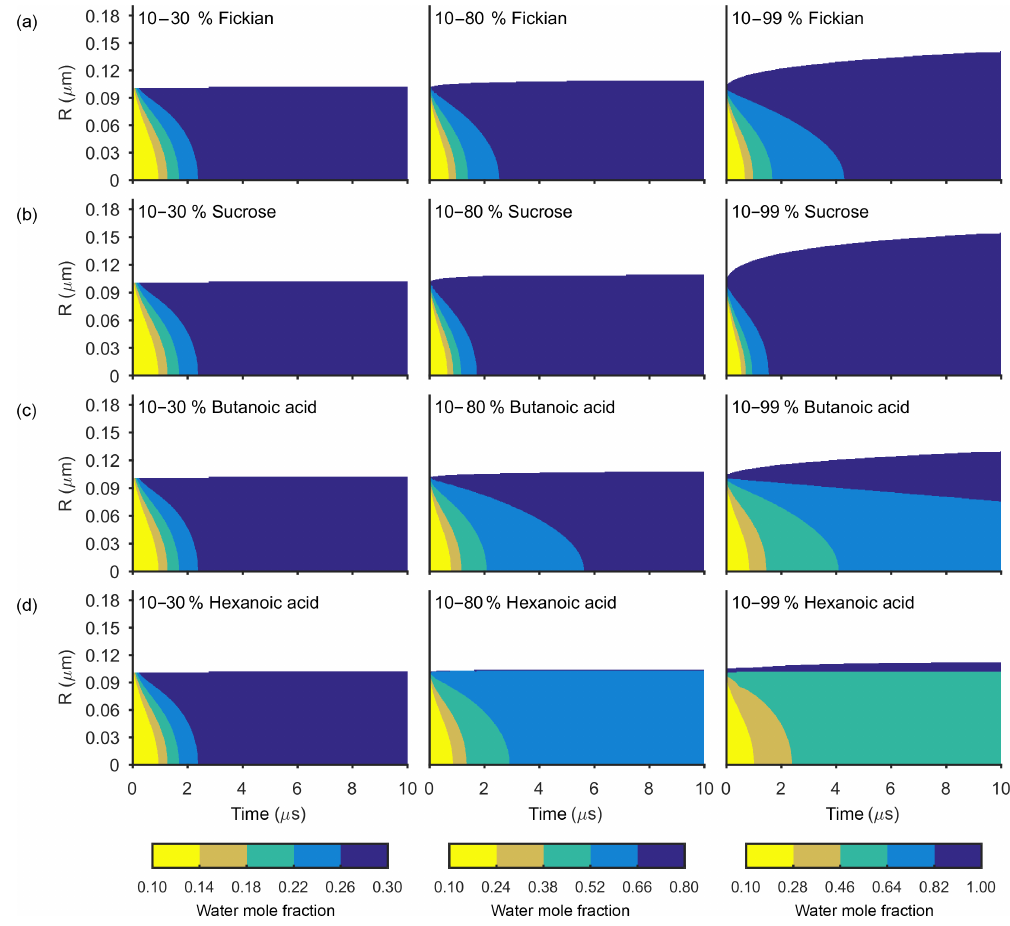
Figure 3. The change in water mole fraction as a function of radius through time after an initial increase in relative humidity from 10 to 30, 80 and 99%, at t = 0 in the left and right column respectively. Note that there is a different colour scale for each column to ensure clarity in the rate of mixing. The rows correspond to different non-volatile substances, with an arbitrary ideal species in the Fickian case, sucrose, butanoic acid and hexanoic acid from top to bottom. These simulations correspond to the Darken diffusion coefficient and thermodynamic factors given in Fig. 2. The aerosol particles were initialized with a radius of 1 × 10 − 7 m and the self-diffusion coefficient of water